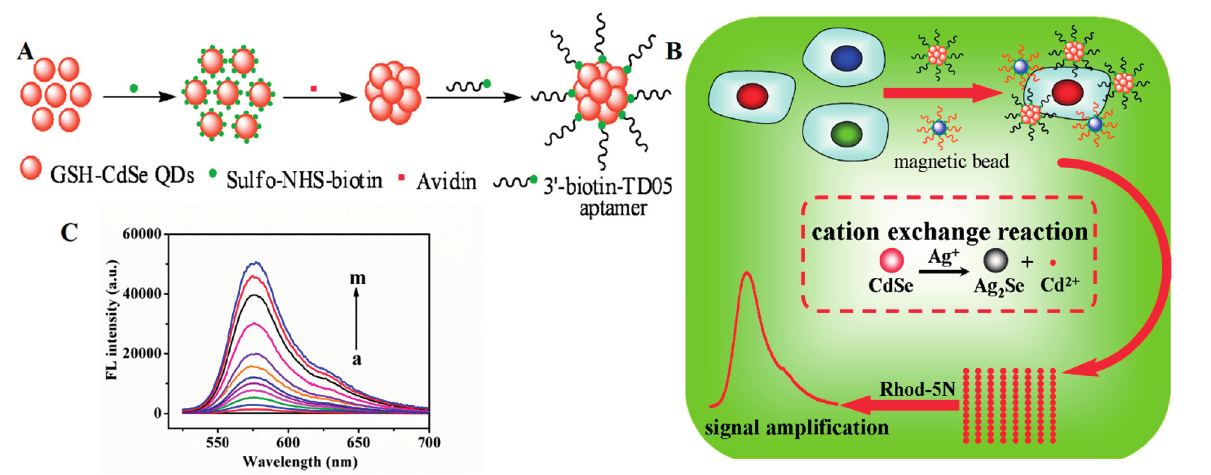
Figure 9. Schematic of the cation exchange based fluorescence method using QD nanoclusters. ( A ) Steps involved in the preparation of Apt-QD nanoclusters; ( B )